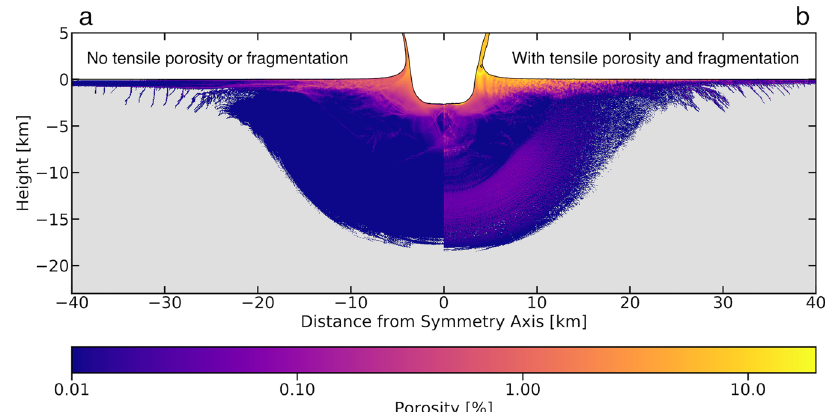
Fig. 1 | Porosity with and without tensile porosity. Result of a 1km diameter impactorintothelunarsurfaceat15km/s.Thelogarithmiccolorbaronthebottom is applicable to both panels; material with 0% porosity is colored gray. Results without the tensile porosity routine or dynamic fragmentation are on the left ( a ) and those including them are on the right ( b ). White color in the fi gures in this paper represents void space, or vacuum. Unless otherwise stated the tensile